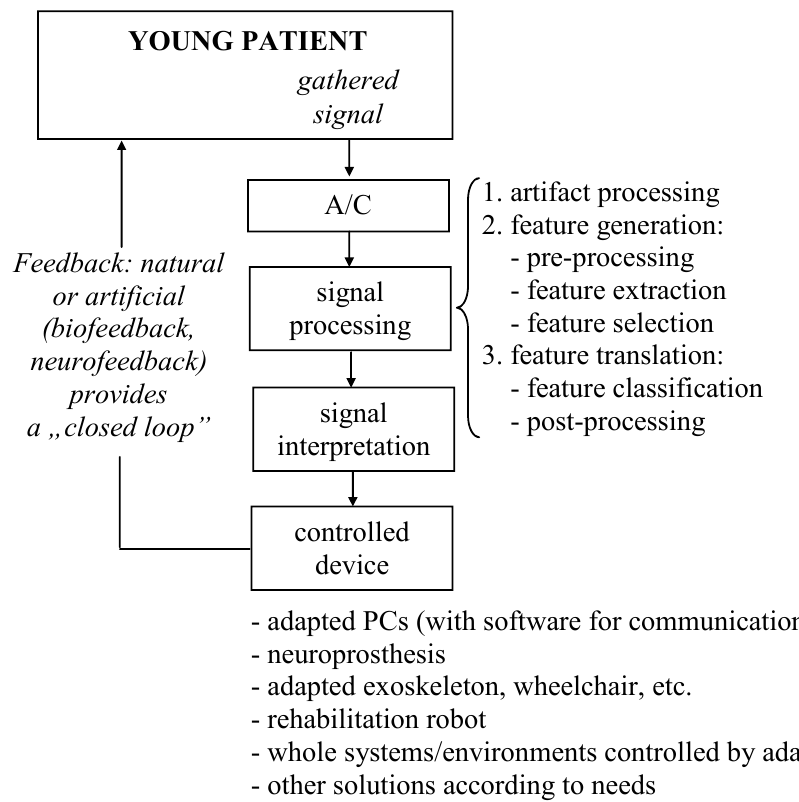
Figure 1. The general brain-computer interface concept [ 2